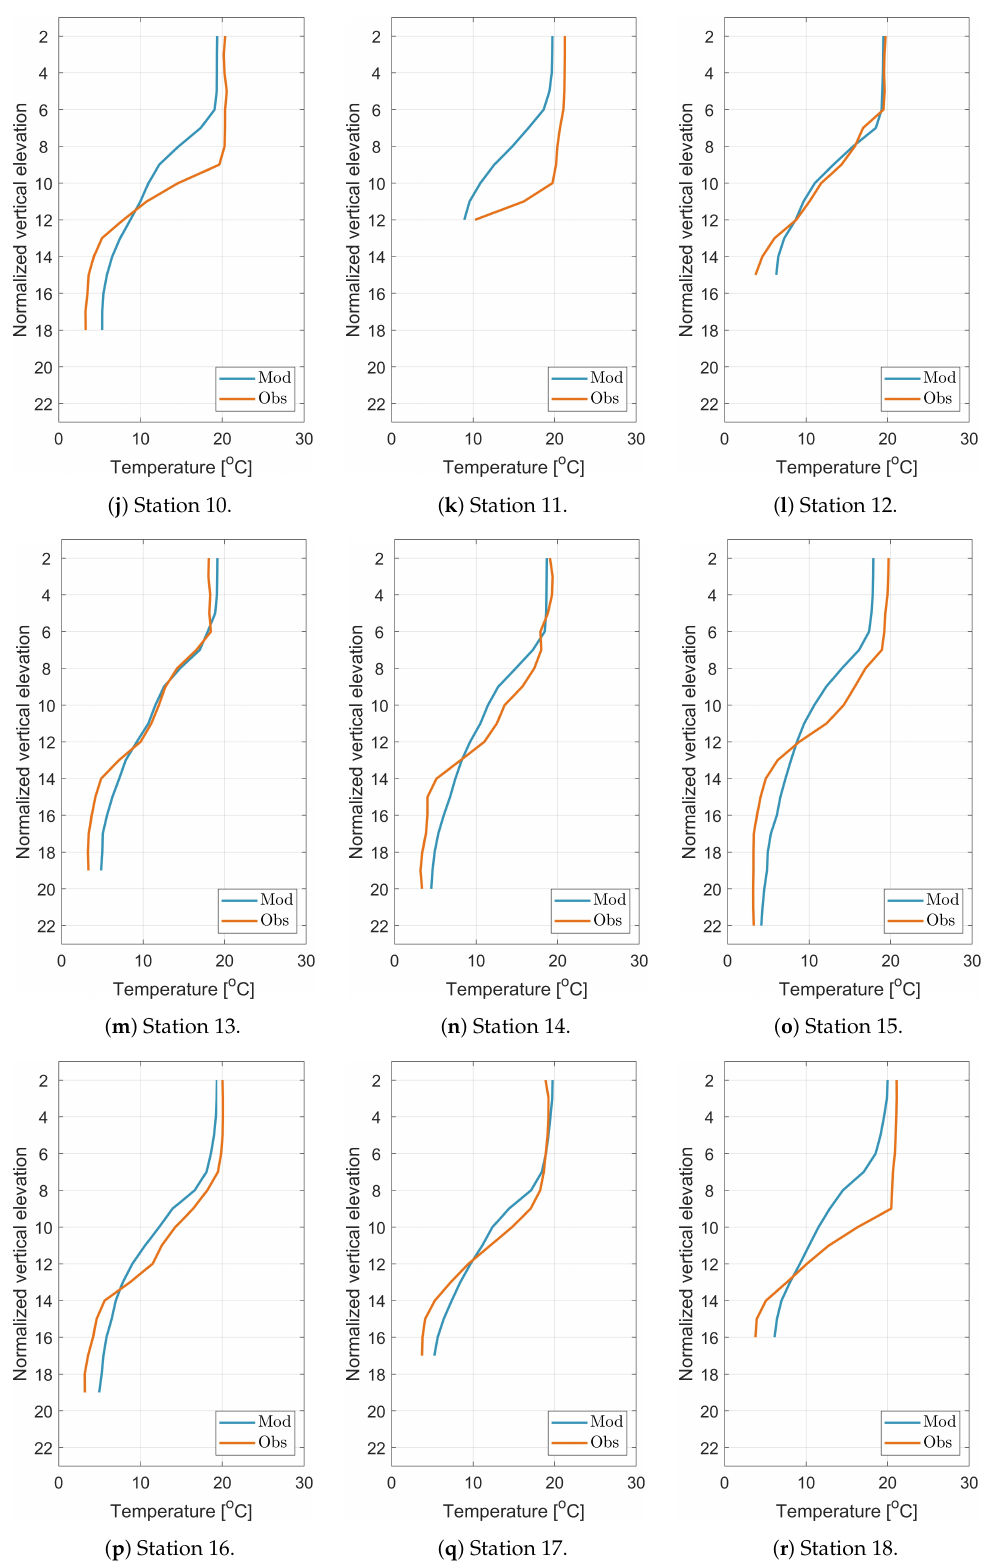
Figure A7. Temperature vertical profiles for all stations compared with s/y Oceania